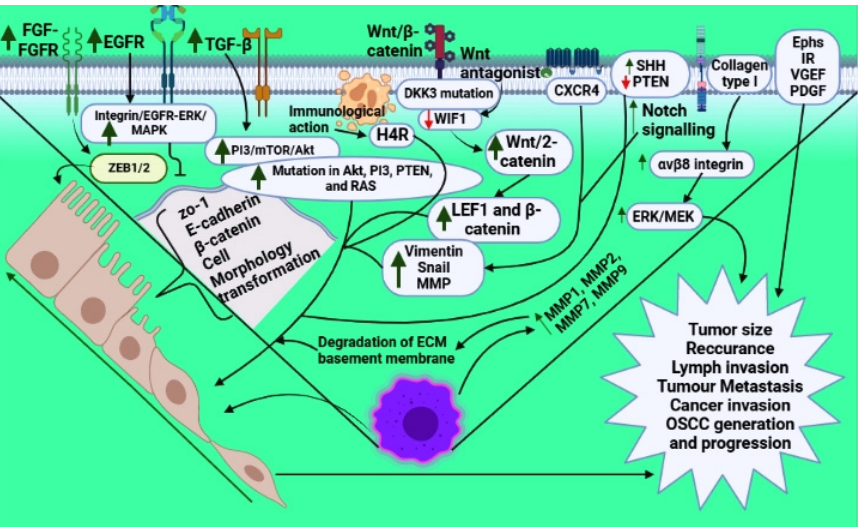
Figure 1. Figure 1 shows the signaling events involved in EMT during oral cancer via different